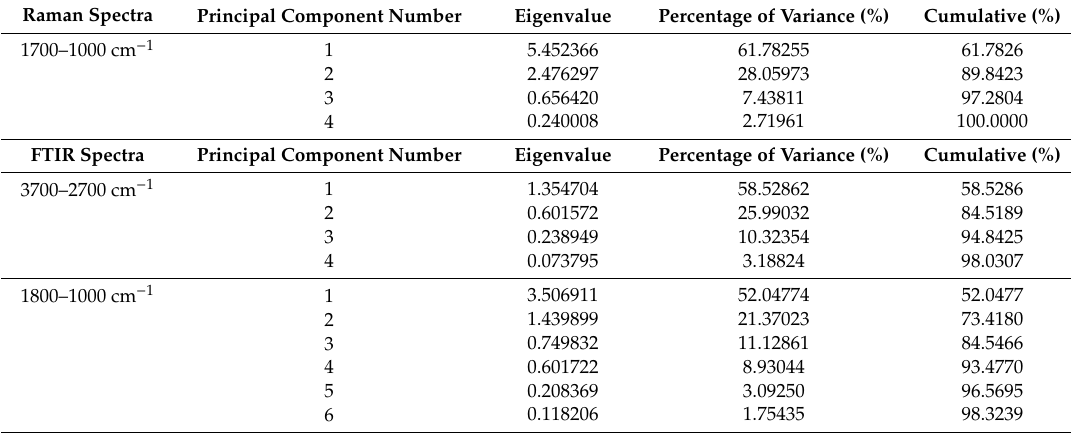
Table 2. Eigenvalues, percentage of variance, and cumulative percentage in the data used for the PCA calculations obtained for the XN cocrystals and the physical mixtures (only for the FTIR data).